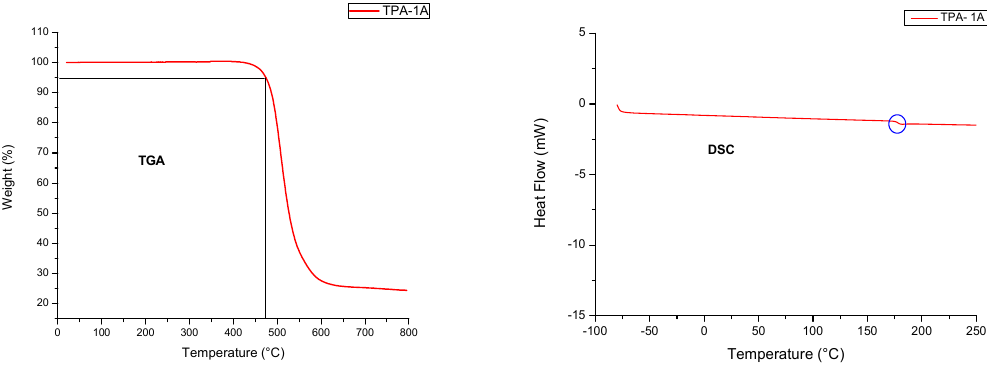
Figure 1. Thermal gravimetric analysis (TGA) and differential scanning calorimetry (DSC) distribution of TPA-1A.